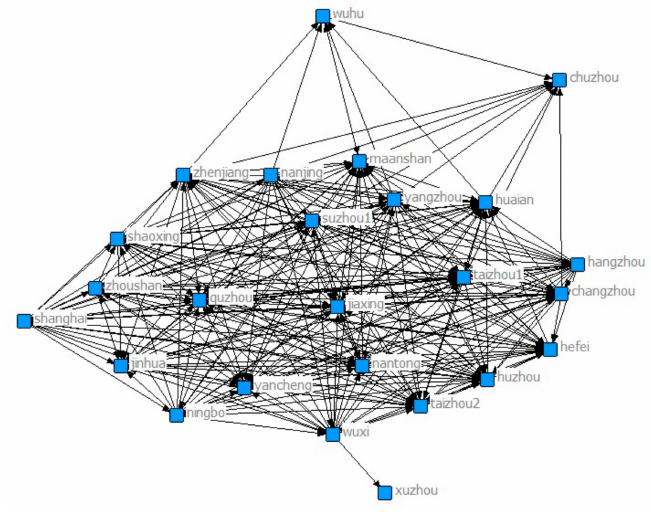
Figure 4. Yangtze River Delta collaborative network in